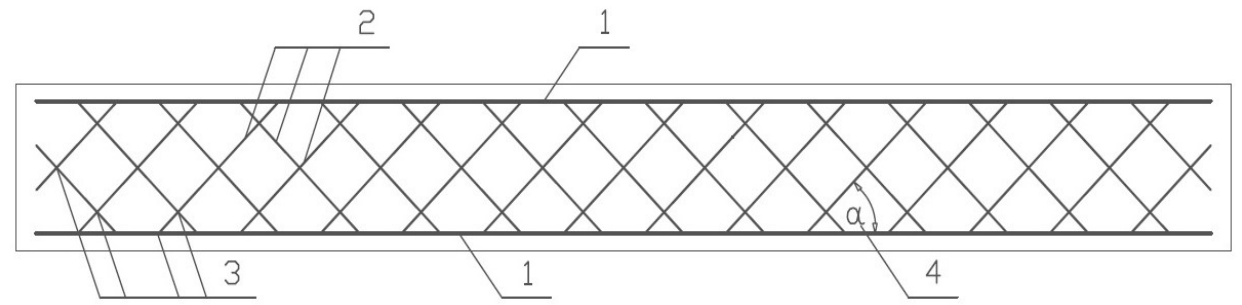
Figure 1. Schema of the truss-shaped reinforcement system of a beam: 1—longitudinal bars (chords), 2—diagonal transverse bars (cross braces), 3—joints of bonding (welding or resistance welding), 4—cross braces inclination angle 30°–60°.